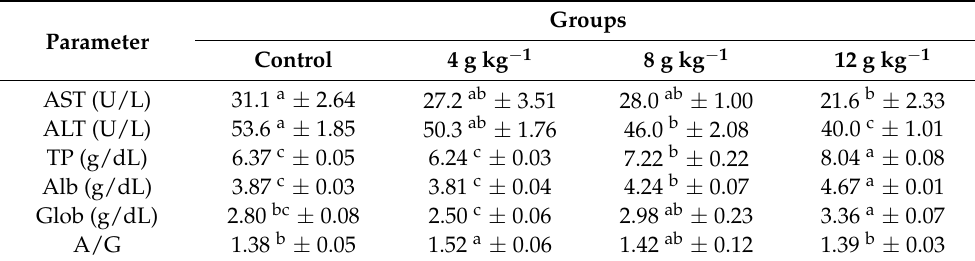
Table 6. Means ± standard errors for liver functions and some blood biochemical parameters of growing ducks are supported by S. marianum dry seeds at different levels (4, 8, and 12 g kg − 1 diet) and control during the brooding period.